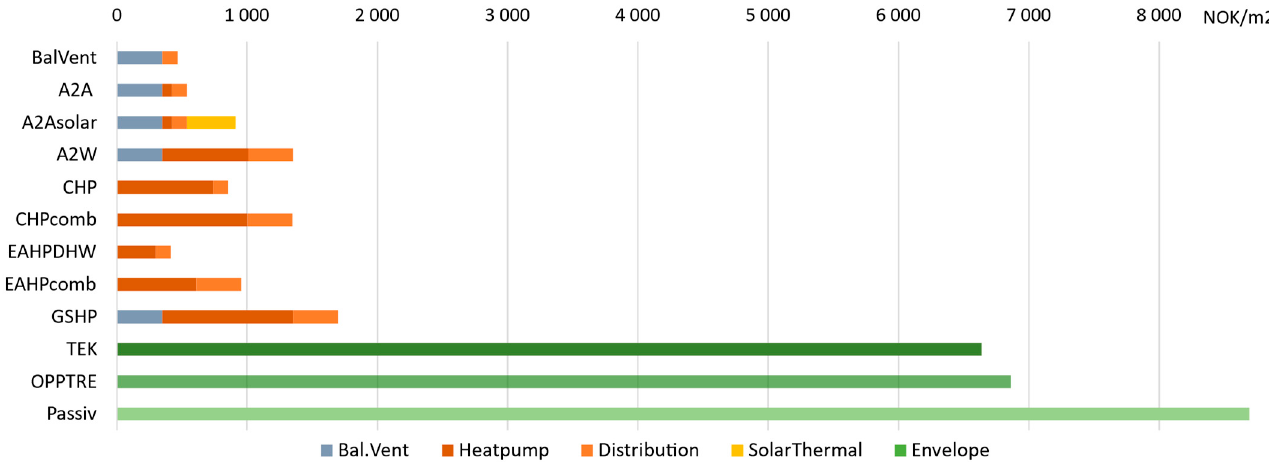
Figure 3. Total specific investment costs for envelope and HVAC systems for the Kristiansand house using the OPPTRE scenario.